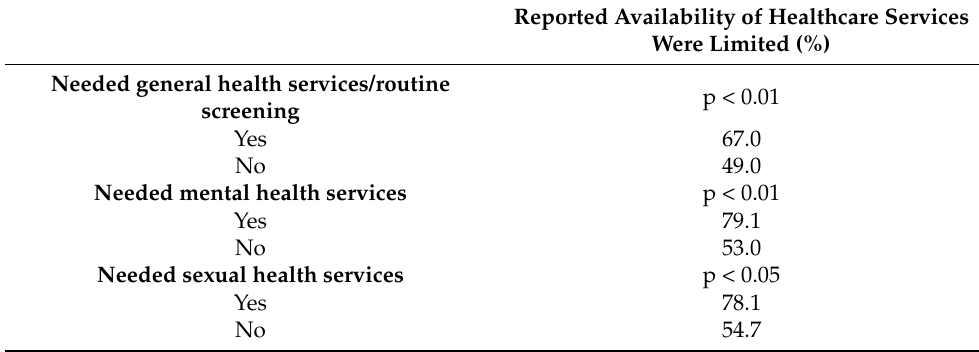
Table 4. Reported limited availability of healthcare services by service